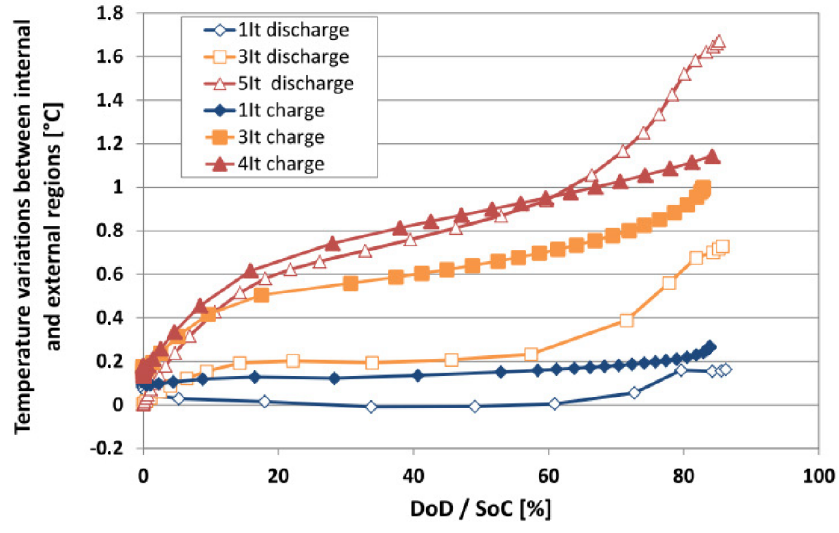
Figure 17. Temperature gradients in the radial direction of the cell during its charge and